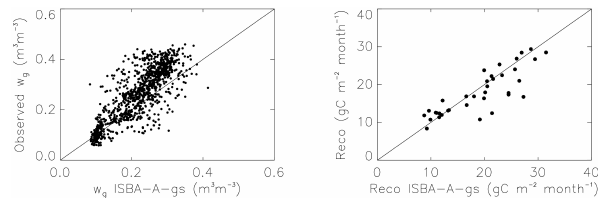
Fig. 8. Surface soil moisture and ecosystem respiration ( w g and R eco ): observations vs. the ISBA-A-gs simulations for a 3-year pe- riod (2005–2007). For w g (left) daily average values are considered. For R eco (right) monthly accumulated values are considered, based on Eq. (4) used in the ISBA-A-gs model or on Eq. (4) with observed w g and soil temperature